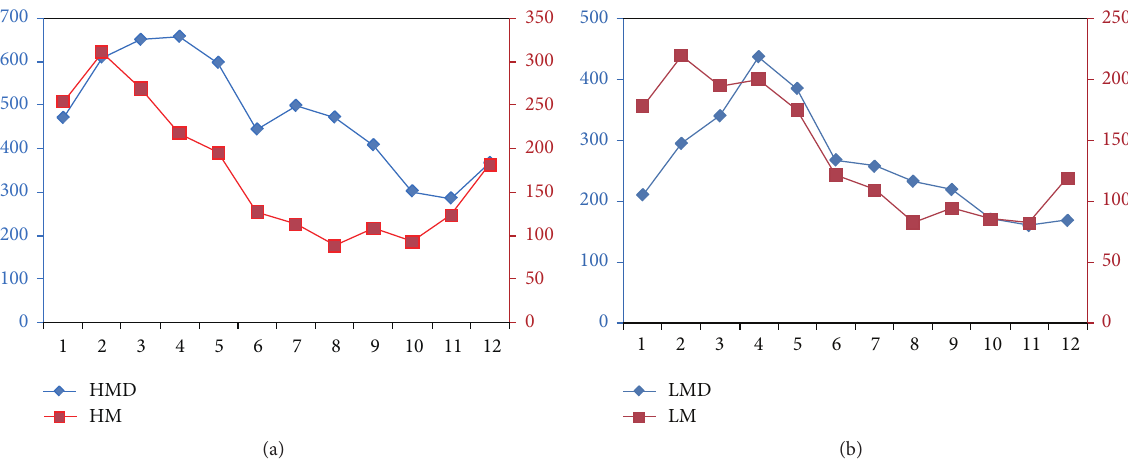
Figure 7: Annual cycles of monthly dust column burden (mgm −2 ) regionally averaged for the Taklamakan Desert (37 ∘ − 42 ∘ N, 78 ∘ − 87 ∘ E) in (a) HMD and HM and (b) LMD and LM.